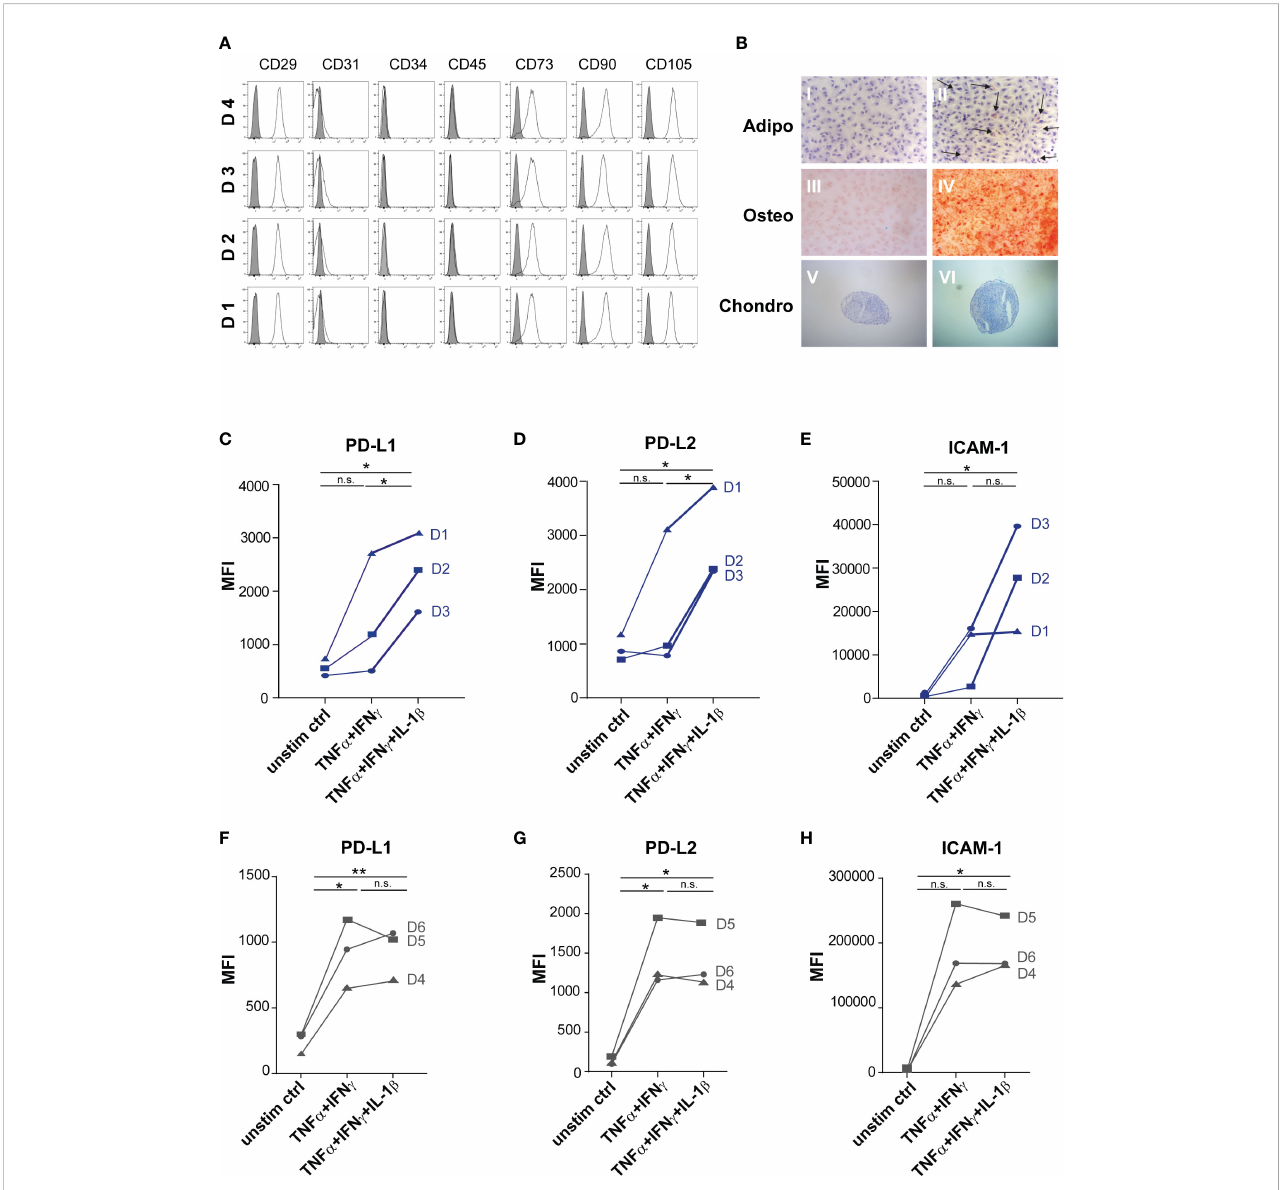
FIGURE 1 Priming with TNF a , IFN g and IL-1 b signi fi cantly increased expression of immuno- modulatory surface proteins of distinct MSCs. (A+B) Routine phenotyping after isolation in 2 nd passage. (A) Flow cytometry analysis of MSCs. Data are shown as an overlay histogram: isotype control (gray) and speci fi c cell-surface markers (white). Cells were labelled with antibodies against CD29, CD31, CD34, CD45, CD73, CD90, and CD105. Dead cells were excluded by live/dead staining. Representative experiments of MSCs used in this study. (B) Trilineage differentiation of MSCs. (I+II) Adipogenic differentiation after 14 days of cultivation with standard culture medium or adipogenic induction medium, sudan III staining (arrow: fat vacuoles); nuclei staining with hematoxylin. (III+IV) Osteogenic differentiation after 21 days of cultivation with standard culture medium or osteogenic induction medium, alizarin red staining. (V+VI) Chondrogenic differentiation after 21 days of cultivation in cultivation with standard culture medium or chondrogenic induction medium, alician blue staining. Representative results from MSCs used in the study. (C – H) MSCs were stimulated by TNF a (1000 U) and IFN g (1000 U) or by TNF a (1000 U) and IFN g (1000 U) in combination with IL-1 b (10ng/ml). (C+F) PD-L1, (D+G) PD-L2, (E+H) ICAM-1 expression were measured by fl ow cytometry, fl uorescence mean intensity (MFI): Marker expression minus isotype. (C-E) “ Full responder ” MSCs show further immunoactivating PD-1 ligand expression after triple-priming (D1-D3, in blue) compared to (F – H) , (D4-D6). Paired t-test was used to test statistical signi fi cance (p < 0.05 considered as signi fi cant), data are means (n=3). Data are shown as individual MSC donors. ns, not signi fi